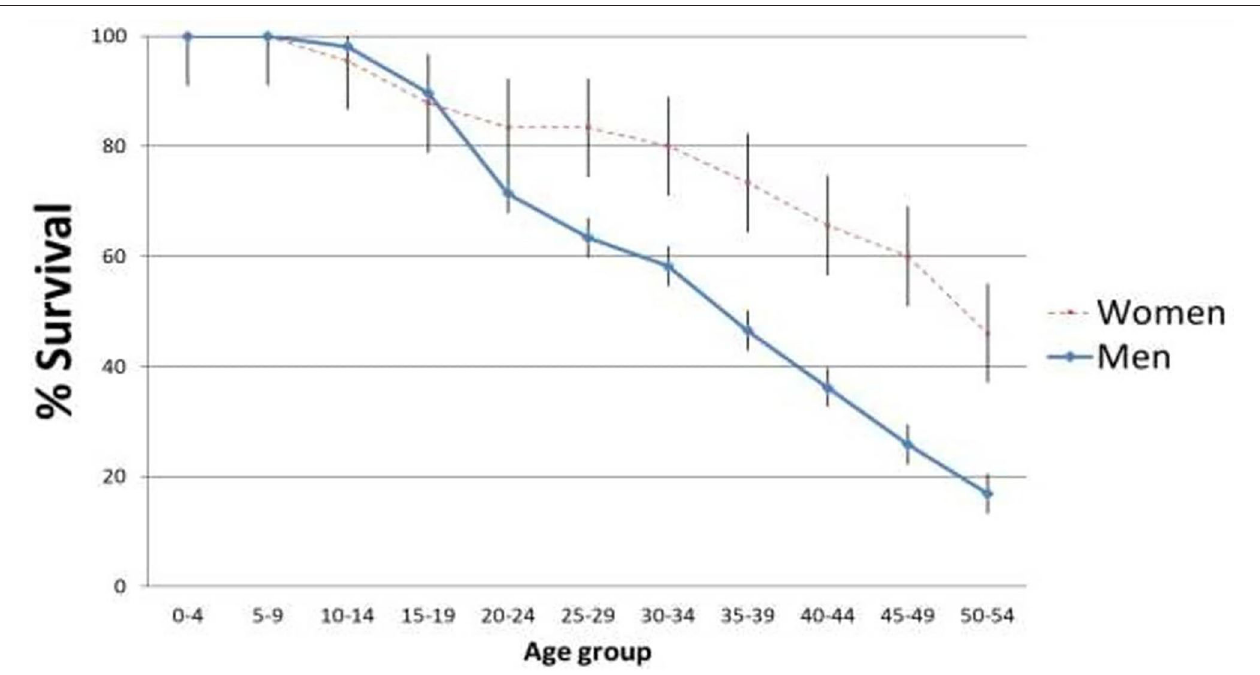
FIGURE 1 | Survival analysis of groups in regards to the occurrence of death. Vertical bars corresponds to standard